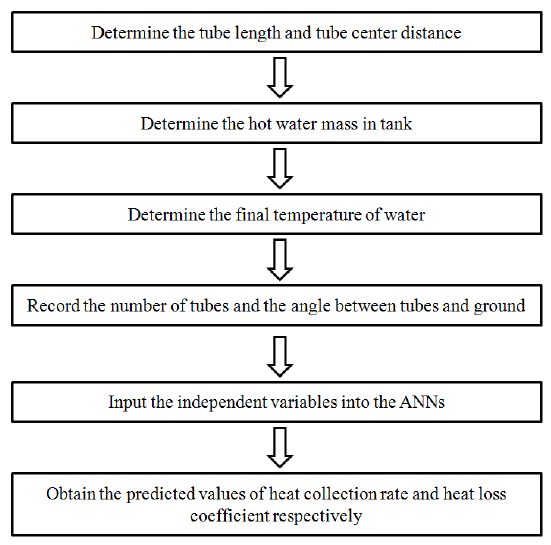
Figure 12. Flow chart of the novel method using “portable test instruments” combined with ANNs for determining heat collection rate and heat loss